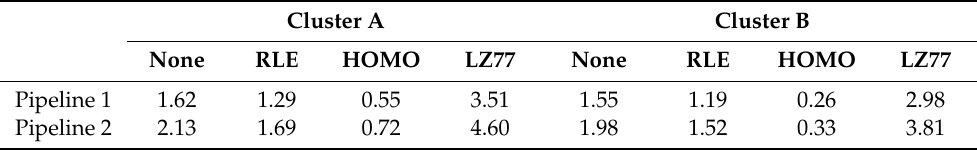
Table 4. Relative speedups of the total execution time for Pipeline 1 and Pipeline 2 compared to the other evaluated methods. Cluster A Cluster